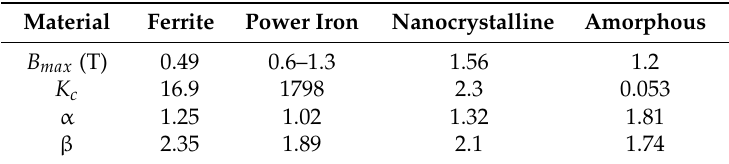
Table 2. Magnetic core loss